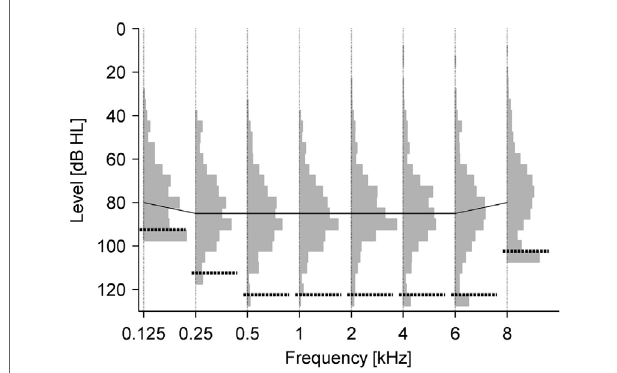
FigUre 2 | Distribution of lDls for individual frequencies . LDL distributions are depicted by gray bars, results where the LDL could not be reached until the intensity limit of the audiometer are separated by dashed black lines. The solid black line denotes the mean LDL.